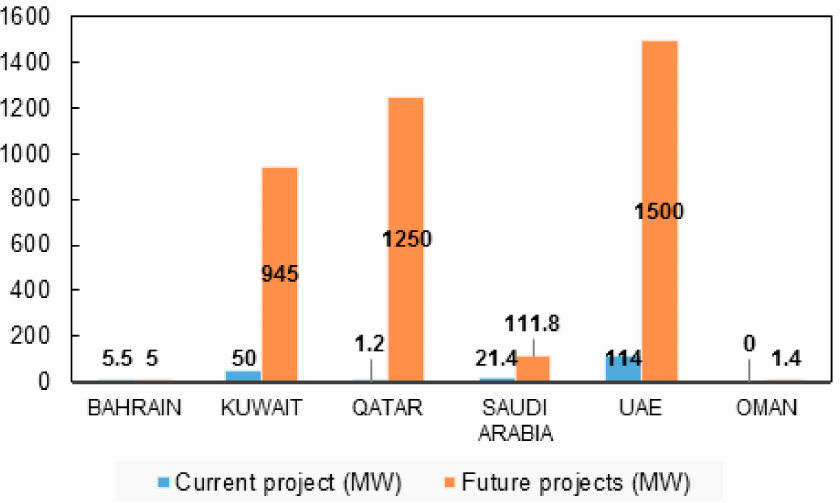
Figure 11. Current and future planned solar projects in the pipeline in the GCC